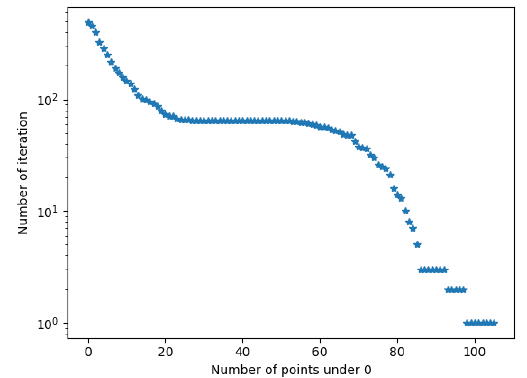
Figure 3. Number of negative G points as function of the number of iterations for a cell aged at 45 ◦